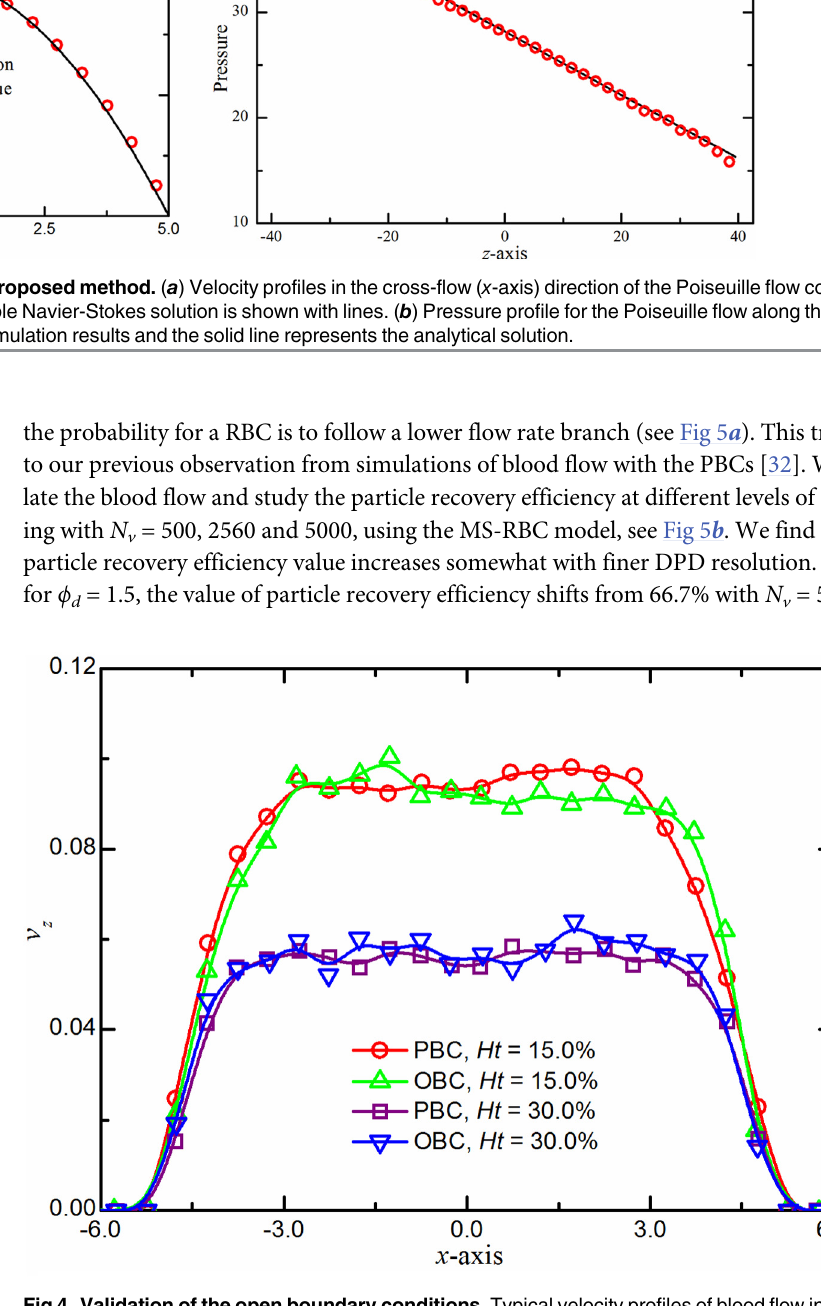
Fig 4. Validation of the open boundary conditions. Typical velocity profiles of blood flow in microtubes at H t = 15.0% and 30.0%. The simulation results are compared to those in periodic systems at same hematocrit levels. x and z represent the radial and axial distances for the cylinder geometry; v z is the velocity along the flow direction.